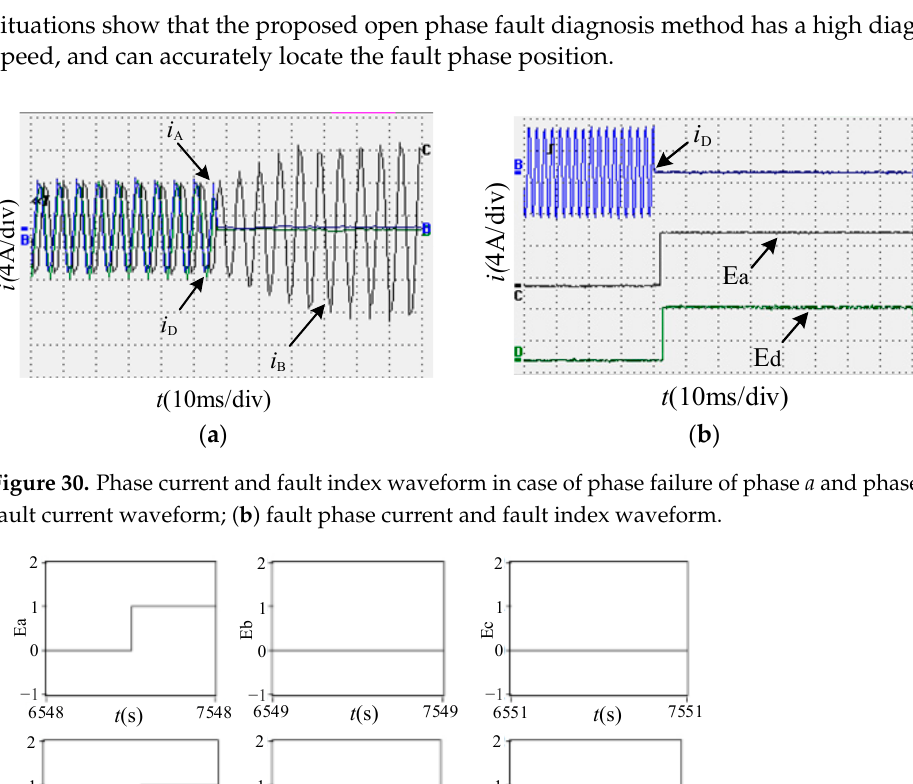
( b ) Figure 28. Phase current and fault index waveform in case of phase failure of phase a : ( a ) fault current waveform; ( b ) fault phase current and fault index waveform. 2506 35062 1 0 −1 E e Figure 29. Fault index waveform in case of phase failure of phase a .